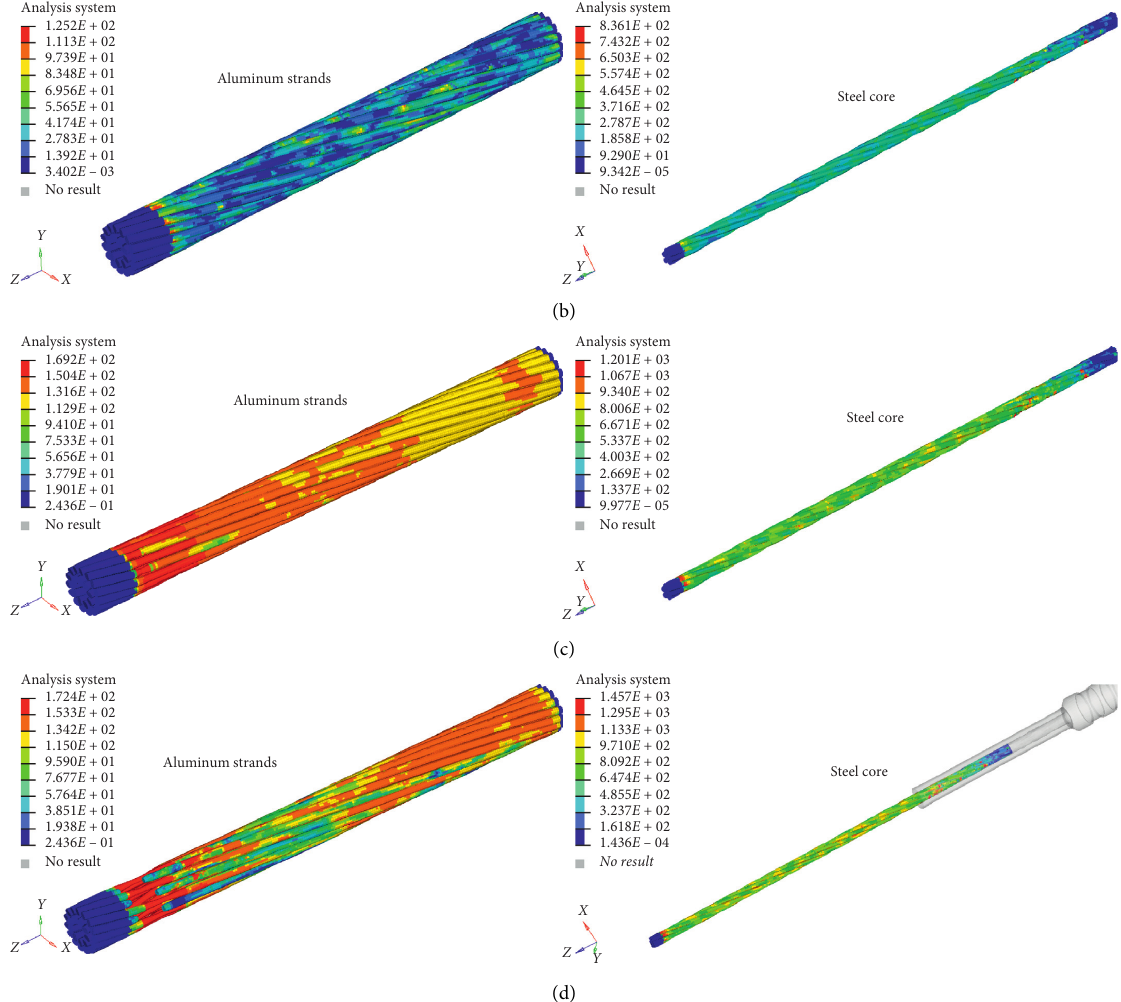
Figure 22: Stress in the aluminum strand and steel core under different tensile loadings: (a) 25% RTS; (b) 50% RTS; (c) 95% RTS; (d) ultimate